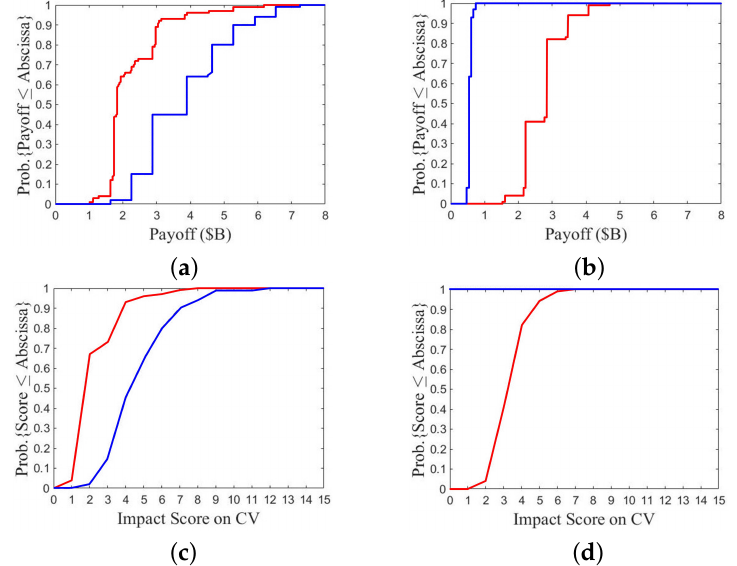
Figure 16. Comparison between A2/B3 and A1/B2 over 100 games with one P 2 SO run. Cumula- tive distribution of payoff, ( a ) A2/B3, ( b ) A1/B2. Cumulative distribution of impact score on CV, ( c ) A2/B3, ( d ) A1/B2. ———: fleet A, ———: fleet